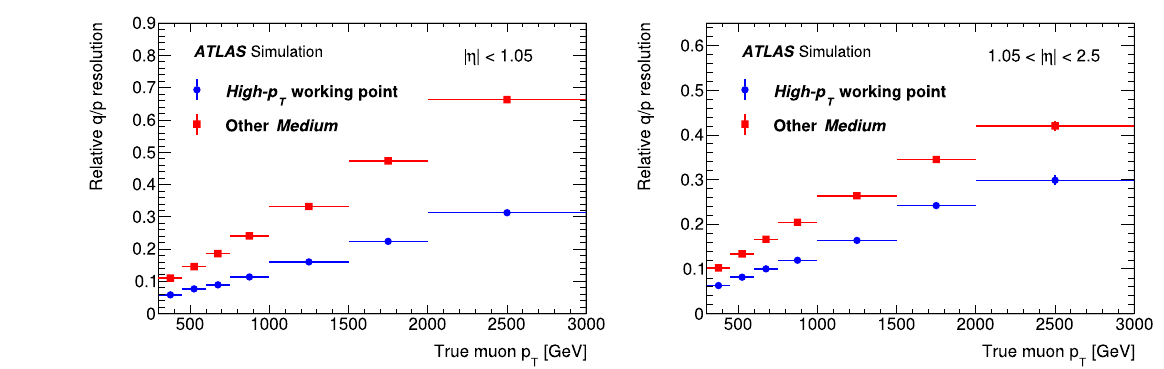
muons passing the Medium WP requirements. The resolutions are eval- uatedinMCsamplesthatincluderealisticmisalignmentscorresponding to the data-taking conditions in